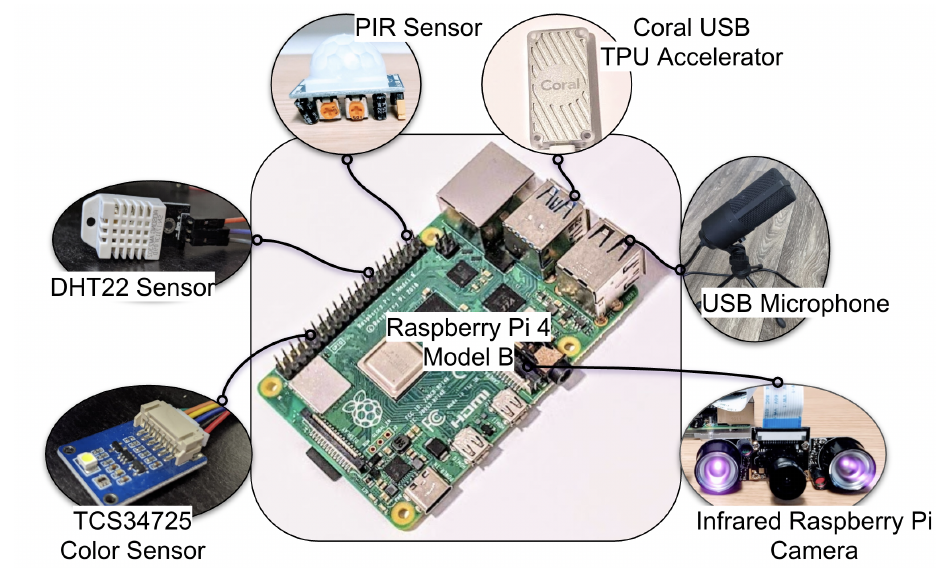
Figure 1. Edge computing and ambient data capture system. (PIR: Passive Infrared Sensor; USB: Uni- versal Serial Bus; TPU: Tensor Processing